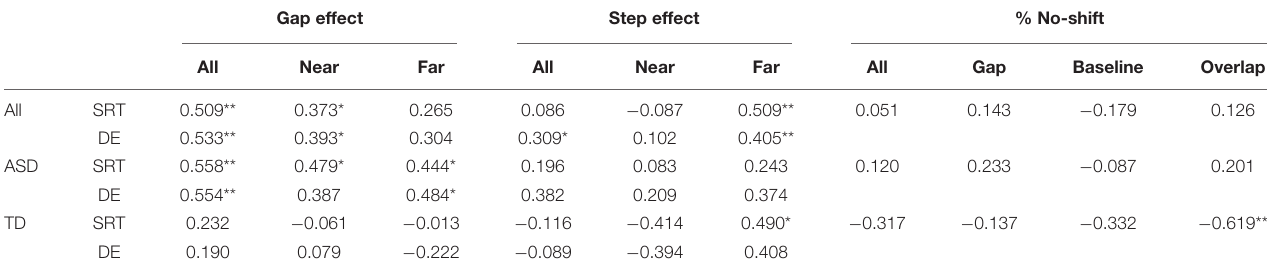
TABLE 3 | Auditory gap-overlap correlations with pupil